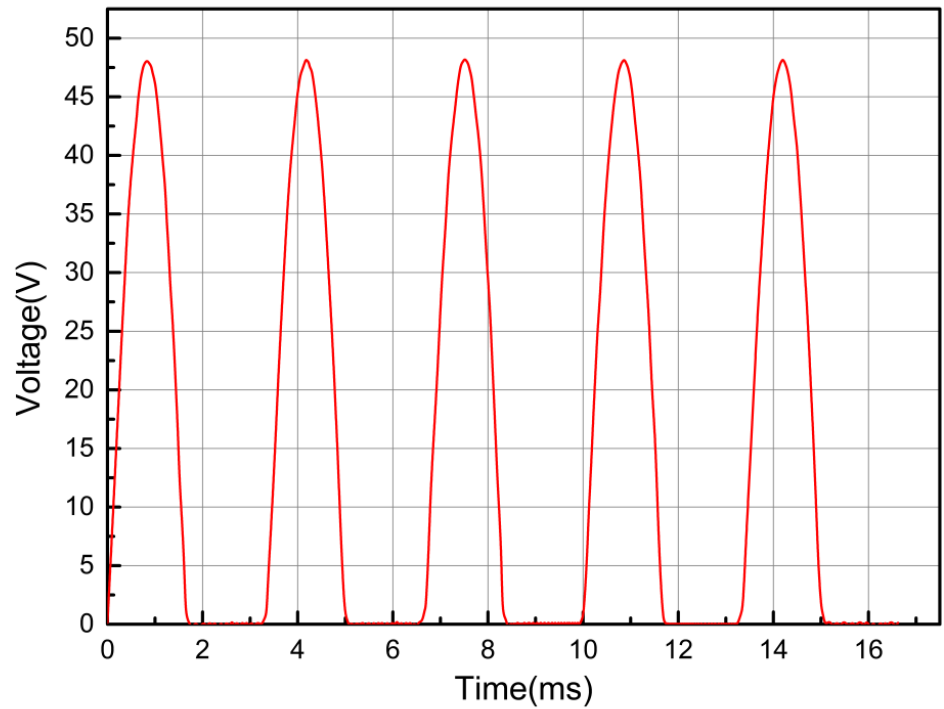
Figure 9. Output voltage waveform at 4000 r/min and no-load.